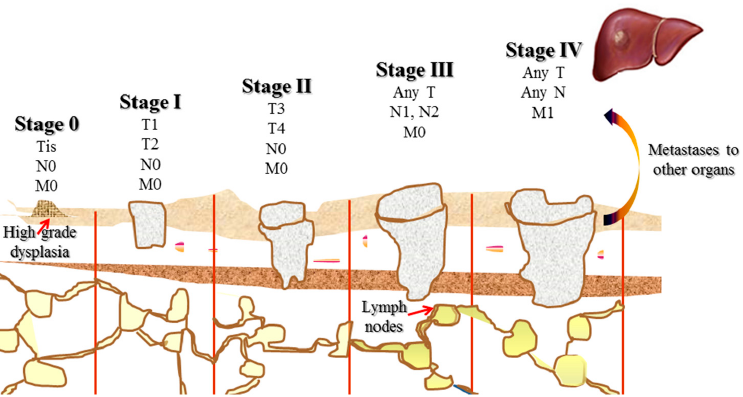
Figure 1. Classification of colorectal cancers (American Joint Commission on Cancer): Tis—carcinoma in situ : intraepithelial or invasion of lamina propria; T1—tumour invades submucosa;